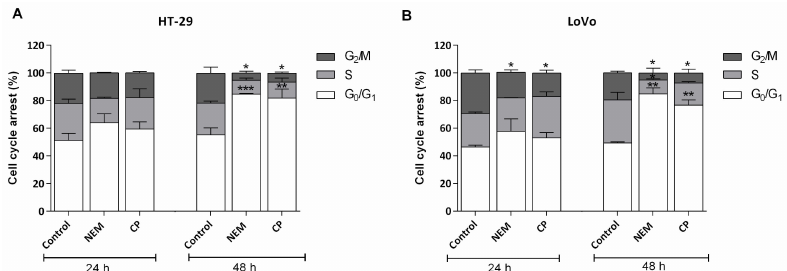
Figure 3. E ff ect of cell cycle distribution of ( A ) HT-29 and ( B ) LoVo cells exposed to NEM (IC 50 ) and CP (IC 50 ) for 24 and 48 h. Results are presented as mean ± S.D. of three independent experiments. * p < 0.05, ** p < 0.01, *** p < 0.001 vs. untreated cells.